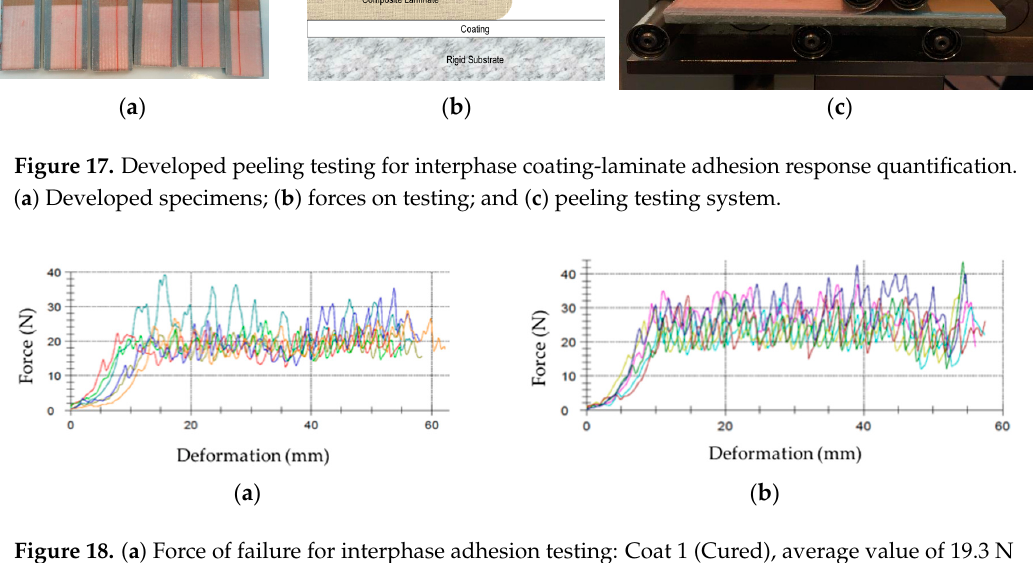
Figure 18. ( a ) Force of failure for interphase adhesion testing: Coat 1 (Cured), average value of 19.3 N (averaged across six samples, plotted in different colors) and ( b ) Coat 2 (Semi-cured), average value of 25.1 N (averaged across six samples, plotted in different colors).